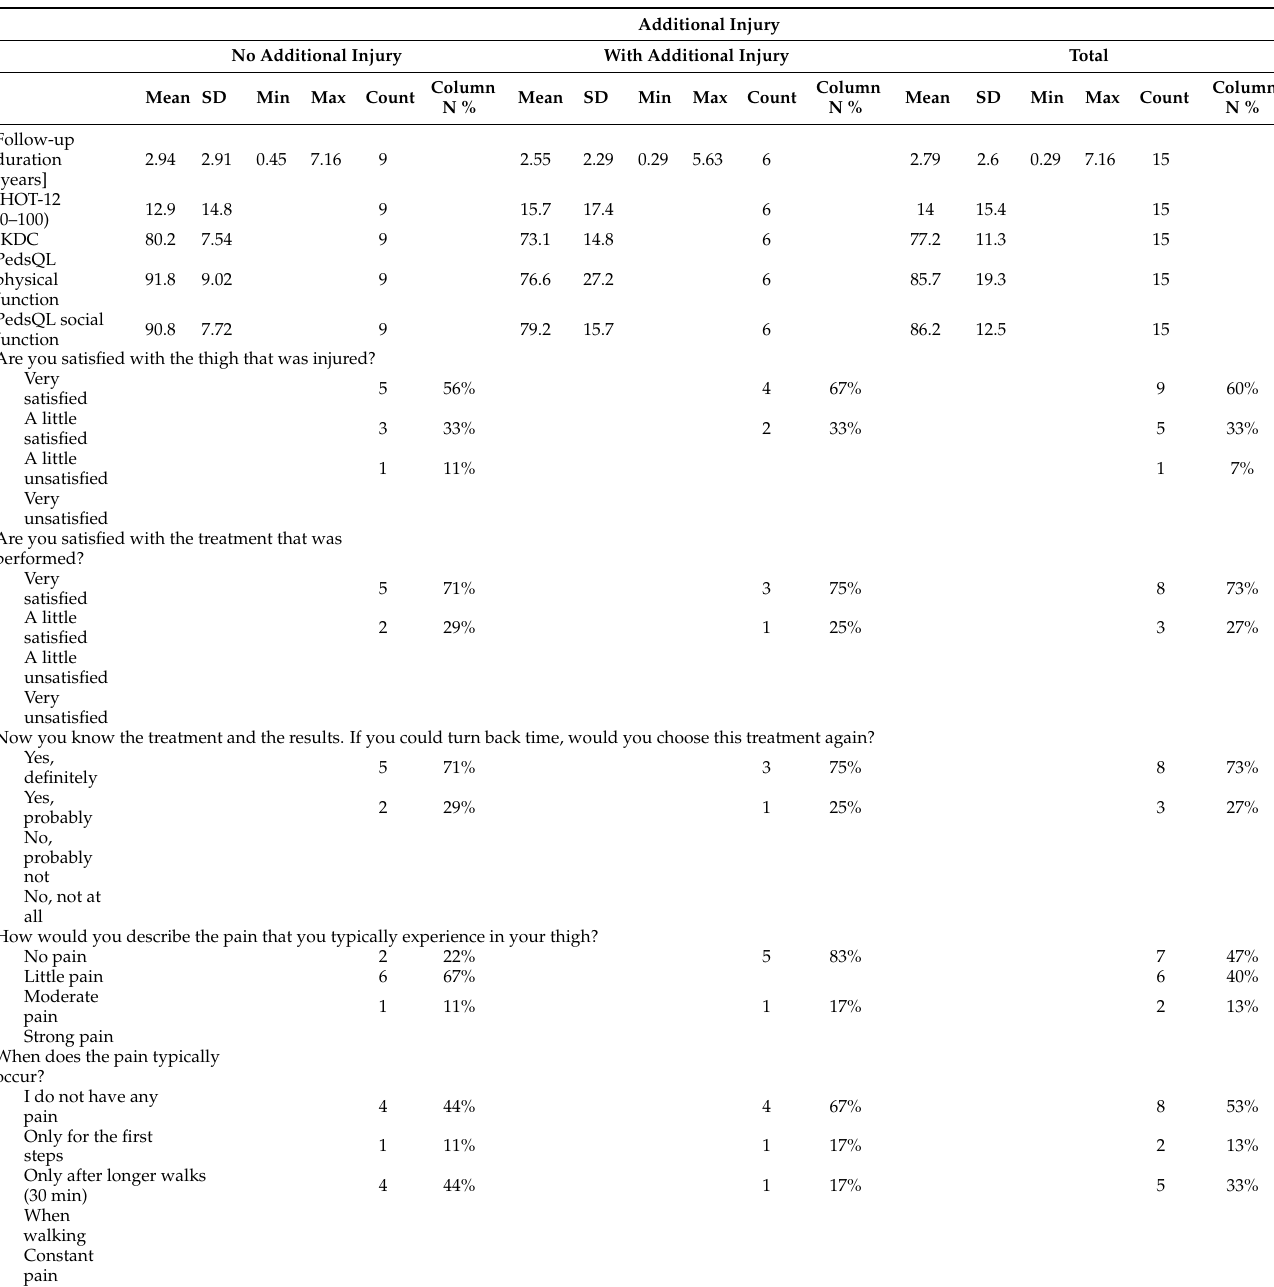
Table 2. Follow-up data by additional